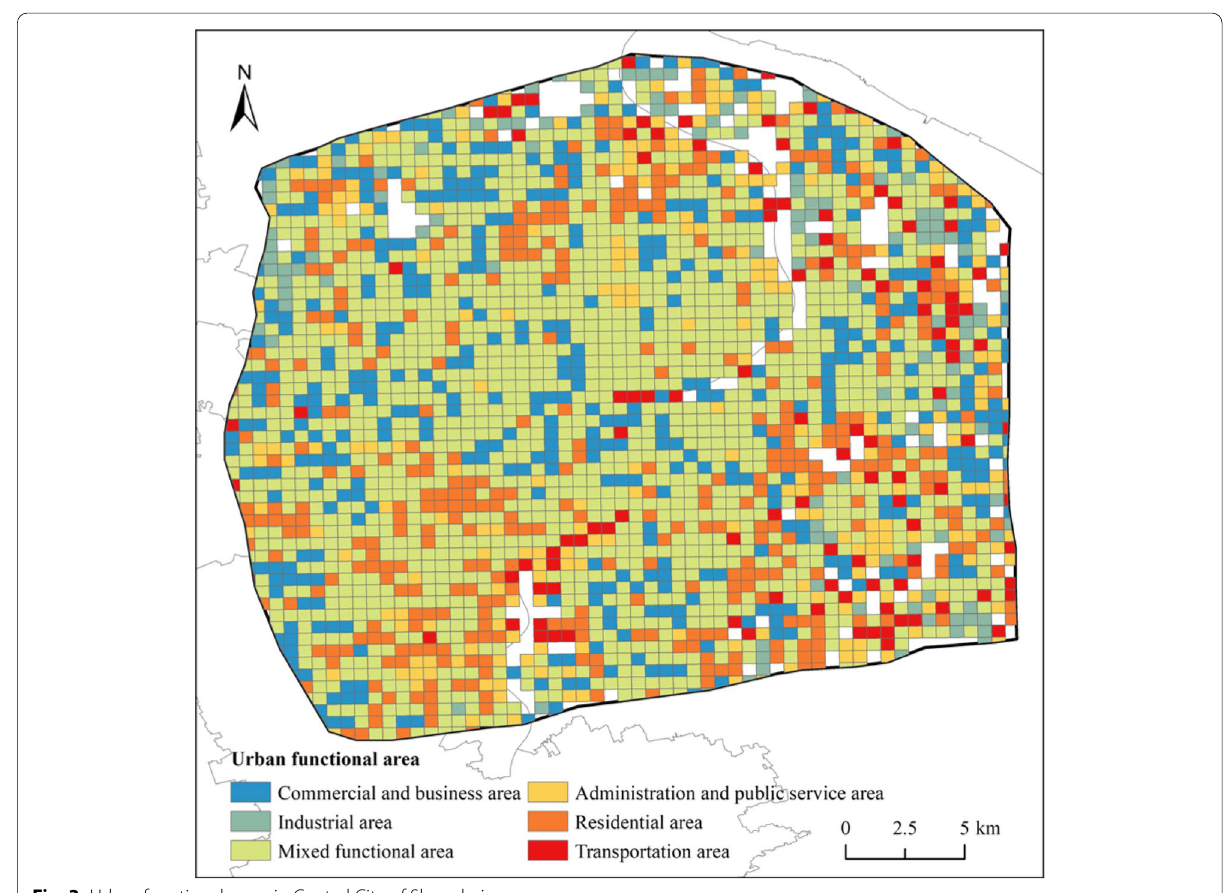
Fig. 3 Urban functional areas in Central City of